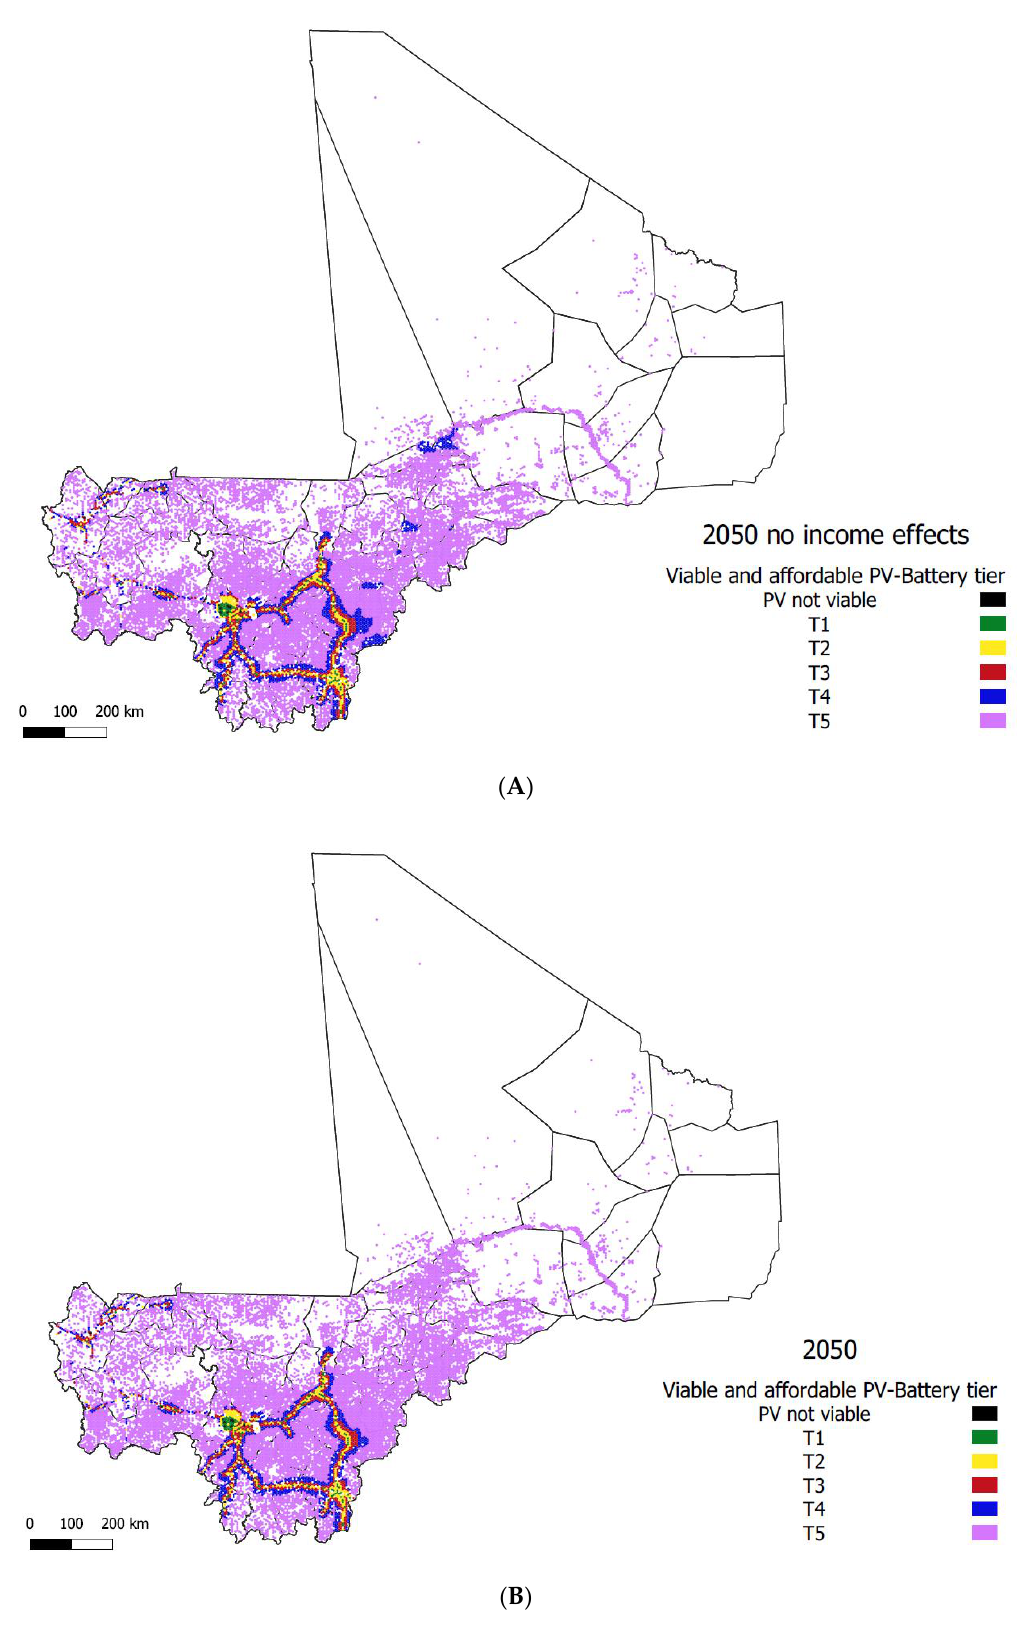
Figure 10. Viable and affordable electrification tier of the geographical units for the assumptions valid for 2050. ( A ) Without the influence of electricity consumption on income. ( B ) Influences of electricity consumption on income are considered.